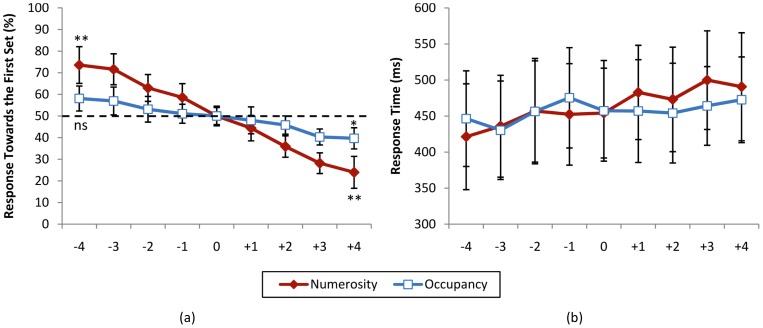
Psychometric function for the control experiment.(a) Percentage response towards the first set and (b) response time for numerosity (n1≠n2, atotal,1 = atotal,2) and occupancy (n1 = n2, atotal,1≠atotal,2) judgement phases. Horizontal axis shows different levels of comparison (n2−n1 for numerosity and atotal,2−atotal,1 for occupancy judgement phase). ** p<0.005, * p<0.025, ns not significant. Error bars reflect one standard deviation.